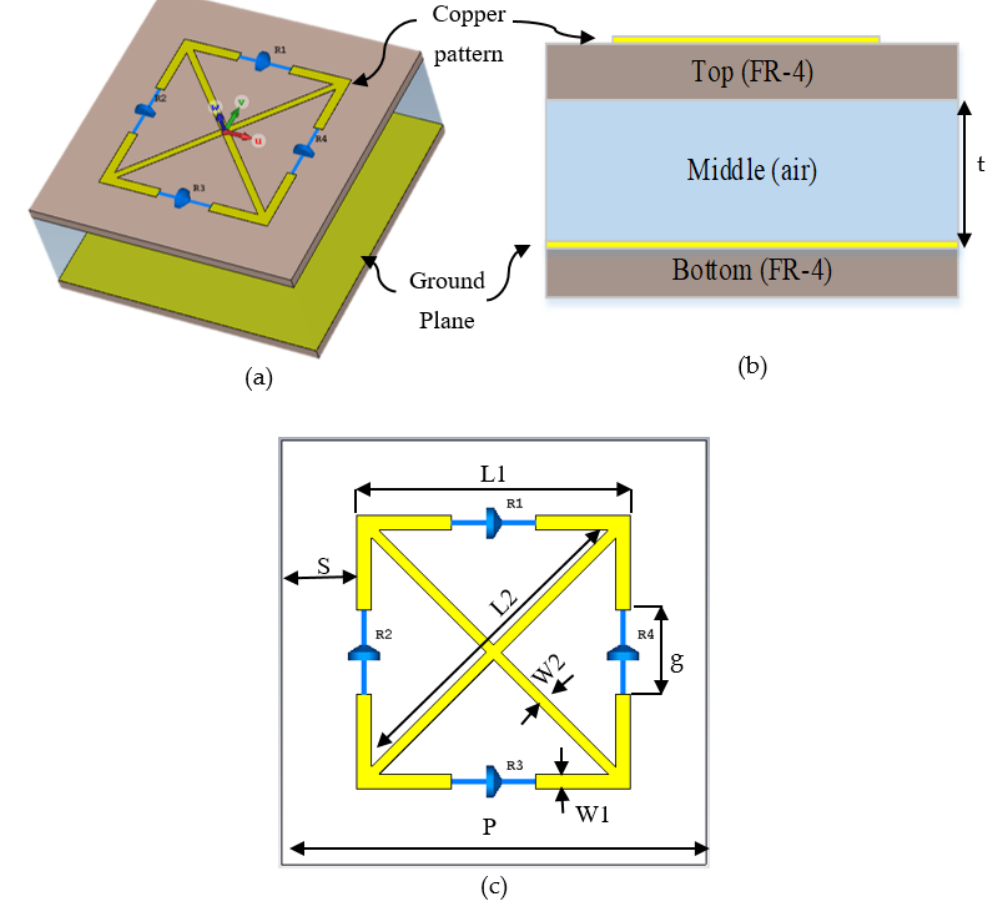
Figure 1. Geometry of proposed MS absorber: ( a ) perspective view, ( b ) side view, and ( c ) top view.